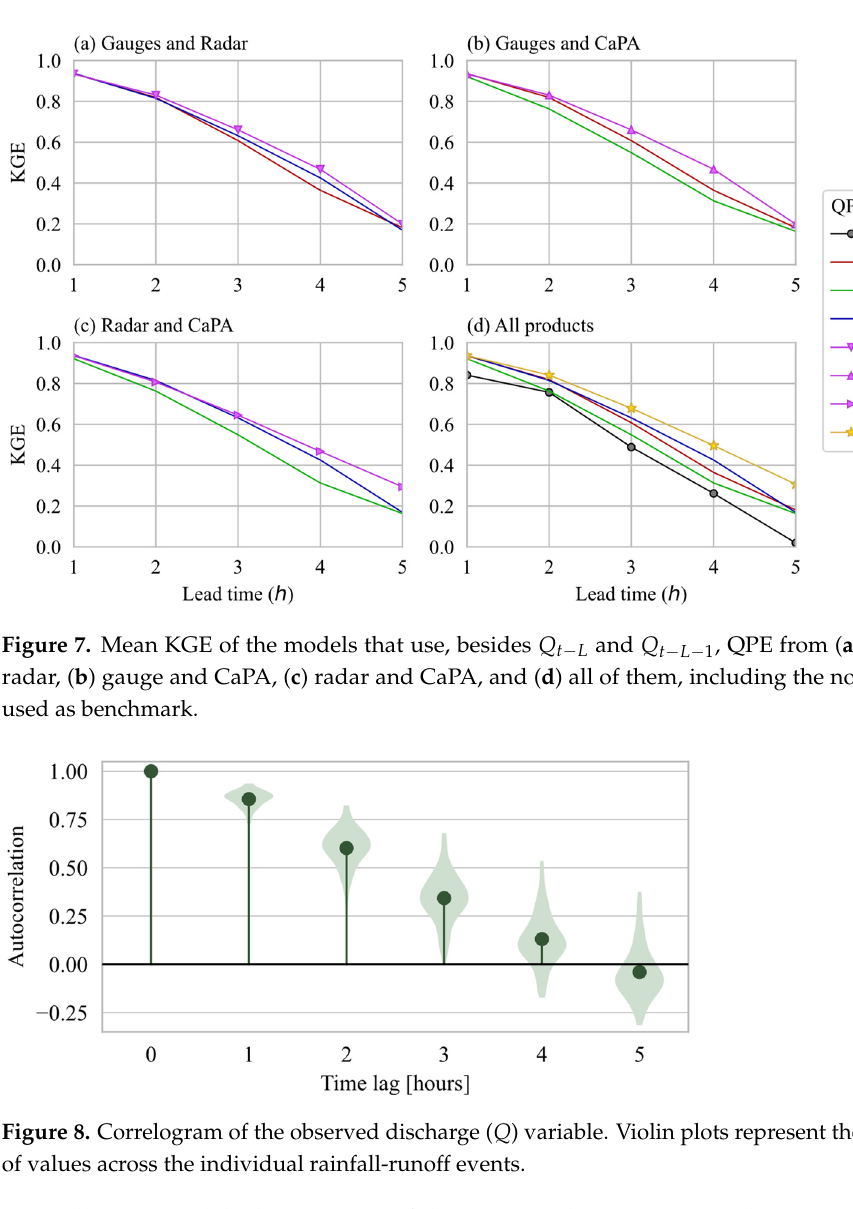
Figure 7. Mean KGE of the models that use, besides 𝑄 (cid:3047)(cid:2879)(cid:3013) and 𝑄 (cid:3047)(cid:2879)(cid:3013)(cid:2879)(cid:2869) , QPE from ( a ) gauges and radar, ( b ) gauge and CaPA, ( c ) radar and CaPA, and ( d ) all of them, including the no-QPE (None) used as benchmark.